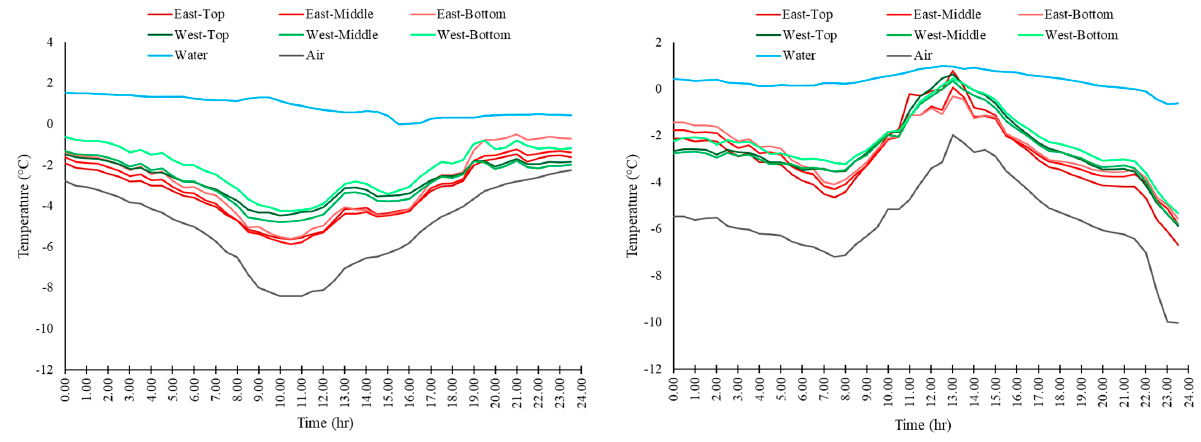
Figure 5. Temperatures of the HDPE tank, water, and ambient on two cloudy days during winter, measured via attached thermocouples.